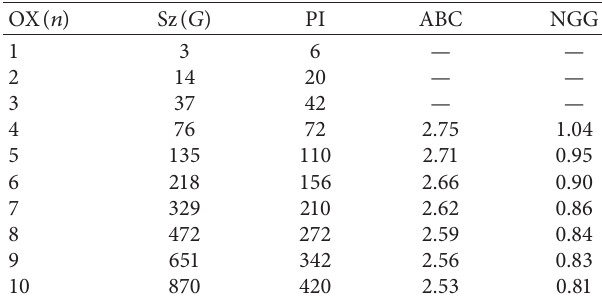
Table 25: Comparison table for chain oxide network.